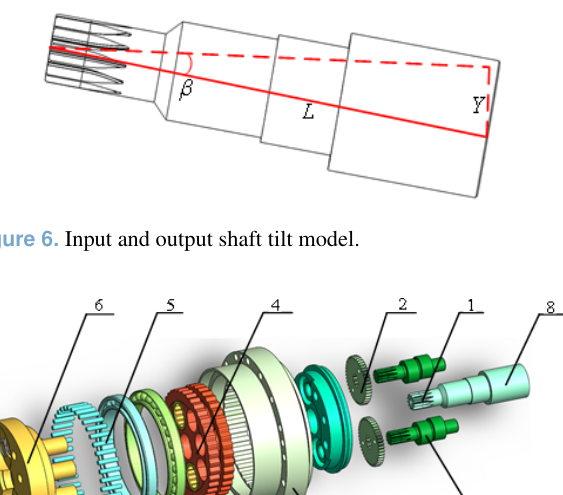
Figure 8. Actual tilt model of input shaft. (a) Normal meshing of input shaft gears (left view). (b) Input shaft gear inclined mesh- ing (left view). (c) Normal parameter model analysis diagram (left view). (d) Analysis diagram of tilt parameter model (left